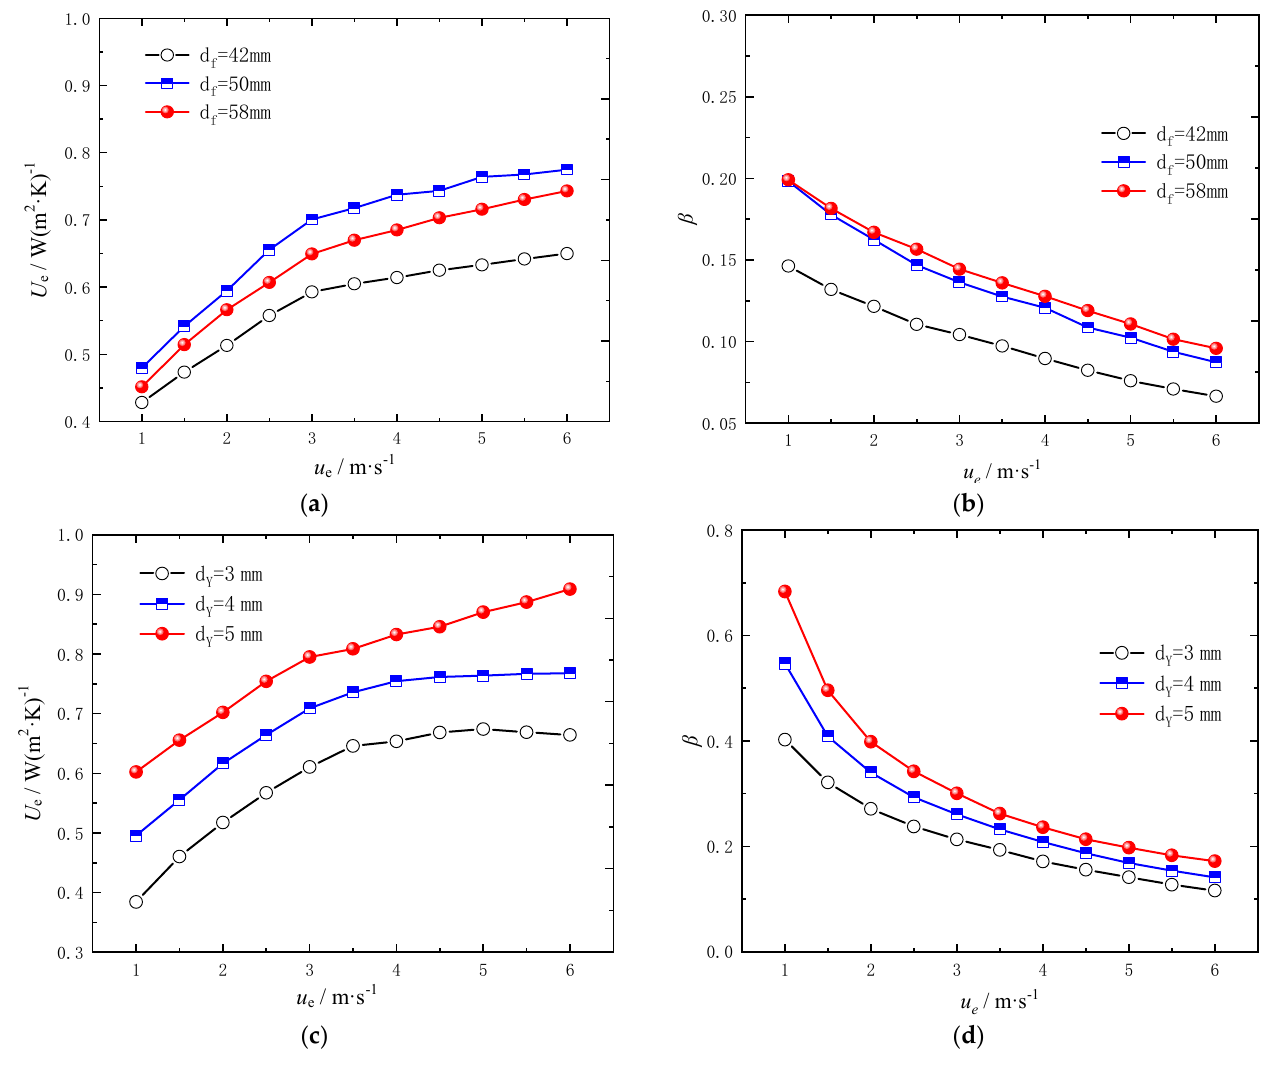
Figure 6. Effects of different fin parameters and cross-section wind speed on dimensionless coefficient, β , and heat transfer coefficient under wet conditions: ( a ) the effect of cross-section wind speed and d f on the heat transfer coefficient; ( b ) the effect of cross-section wind speed and d f on dimensionless factor, β ; ( c ) the effect of cross-section wind speed and d Y on the heat transfer coefficient; ( d ) the effect of cross-section wind speed and d Y on dimensionless factor β .